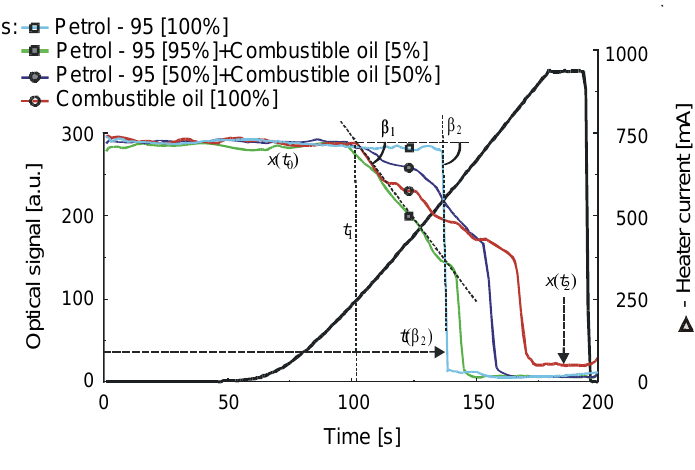
Figure 14. The vapor phase creation in selected fuel